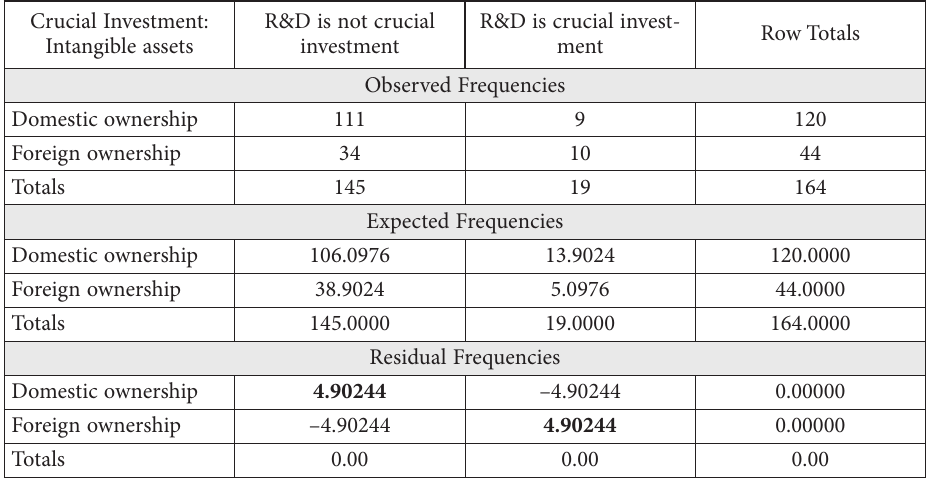
Table 9. Contingency: foreign ownership × research and development – frequencies (source: own) Crucial Investment: Intangible